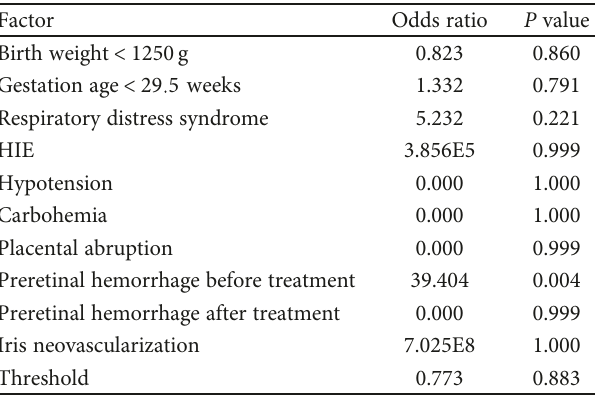
Table 2: Multivariate logistic regression analysis of risk factors for the recurrence of retinopathy of